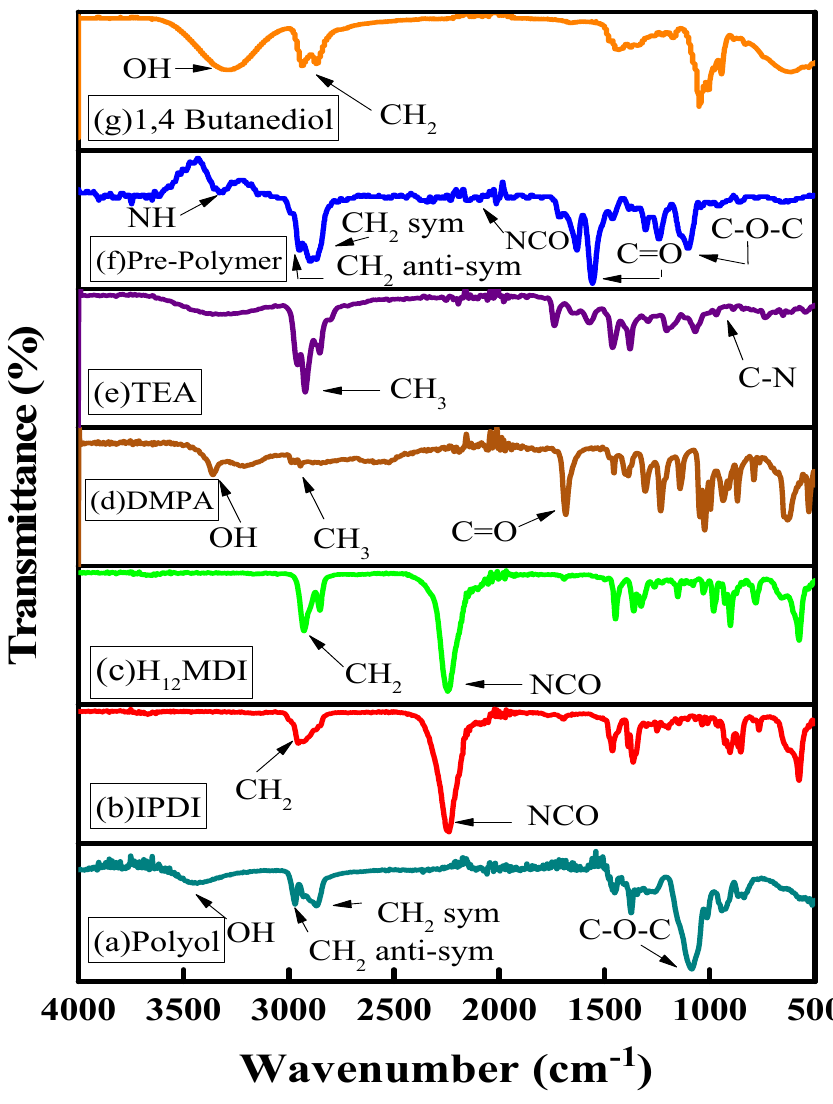
Figure 2. FTIR spectra of monomers and the prepolymer of WPUDs dispersions. ( a ) Polyol: the spectrum of the castor-oil-derived monomer; ( b ) IPDI: the spectrum of isophorone diisocyanate; ( c ) H 12 MDI: the spectrum of dicyclohexylmethane-4,4 ′ -diisocyanate; ( d ) DMPA: the spectrum of dime- thylolpropionic acid; ( e ) TEA: the spectrum of triethylamine; ( f ) the spectrum of prepolymer; ( g ) the spectrum of the chain extender.